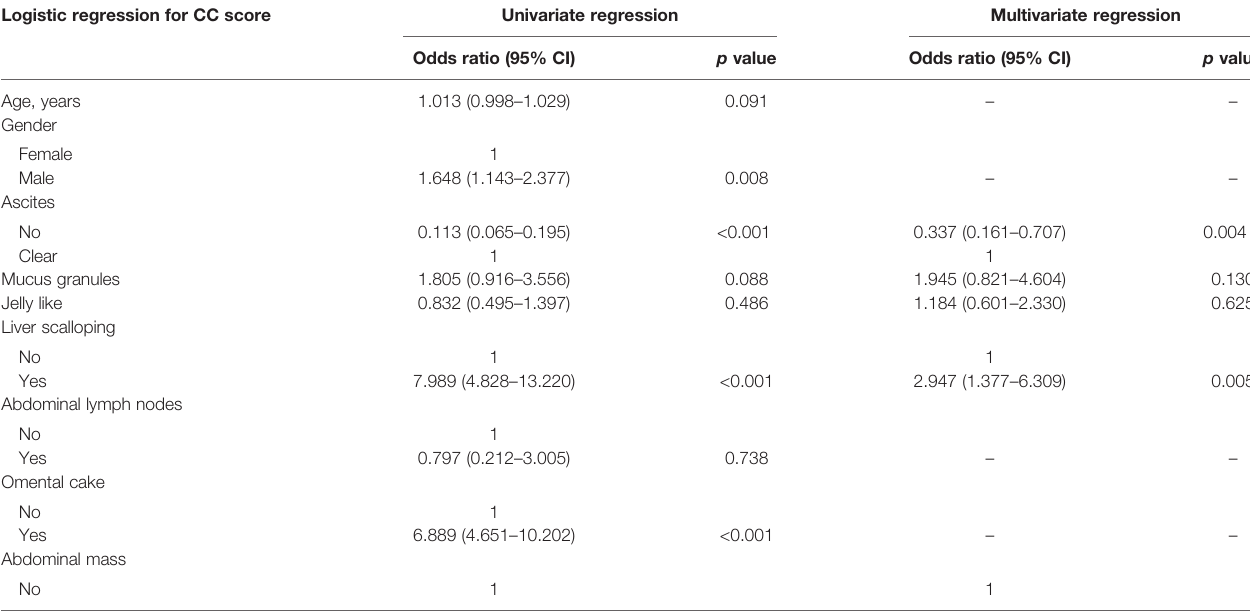
TABLE 4 | The univariate and multivariate logistic regression for CC score. Logistic regression for CC